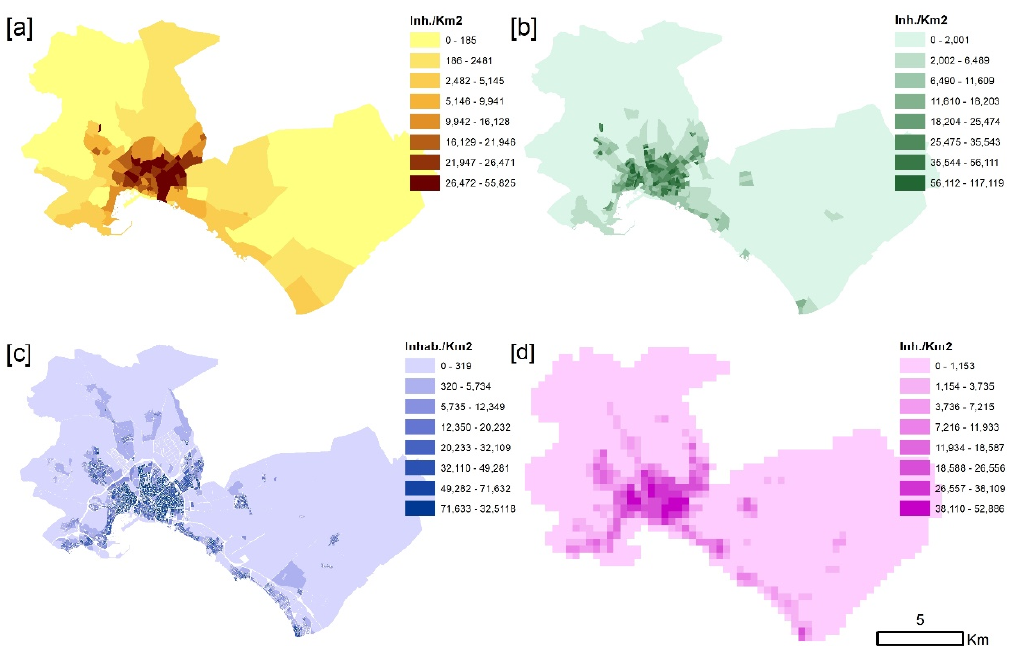
Figure 2. Population density of the municipality of Palma: ( a ) Neighbourhoods; ( b ) Census sections; ( c ) Cadastral blocks; and ( d ) 400 × 400 m mesh.